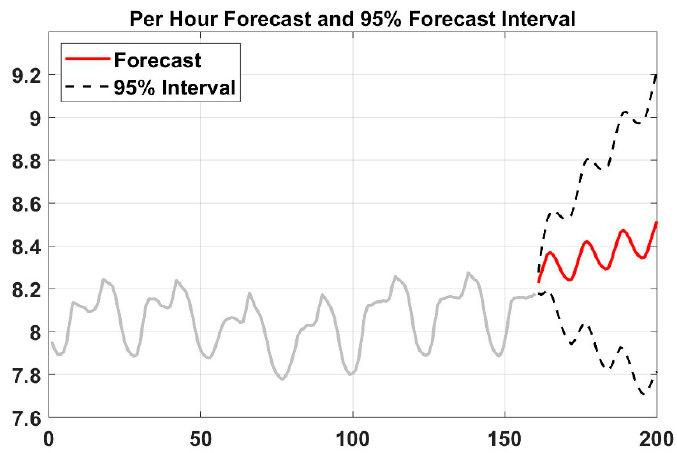
Figure 23. Per hour forecasting validation using ARIMA.